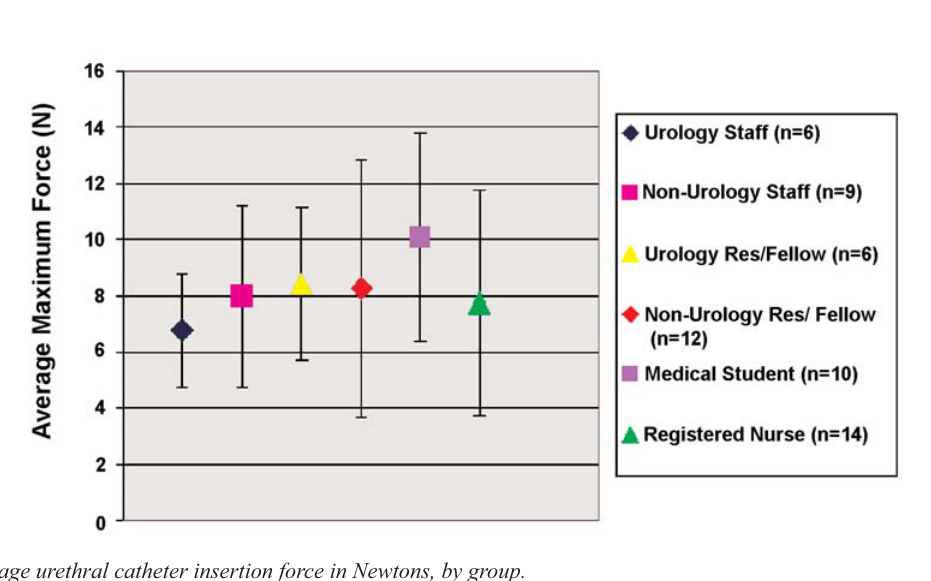
Figure 2 – Average urethral catheter insertion force in Newtons, by group.